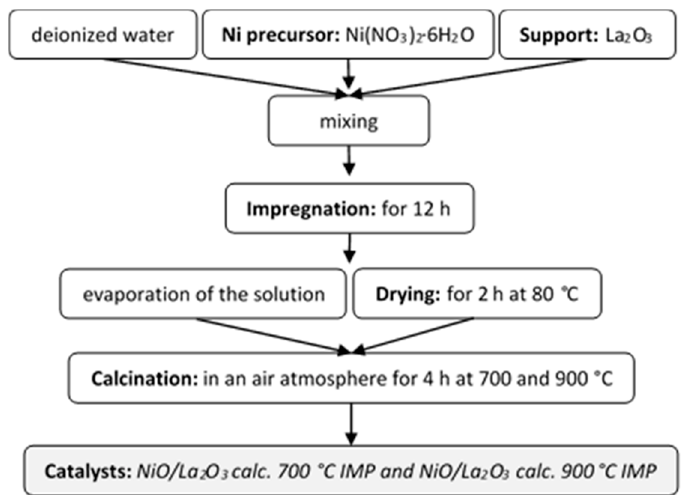
Figure 9. Synthesis diagram of NiO/La 2 O 3 IMP catalysts calcined in air atmosphere for 4 h at 700 °C and 900 °C.